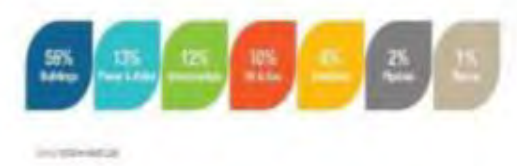
Figure 4. Sector-wise Construction Budget Distribution (2015) (”Jeddah Chamber”, 2016).